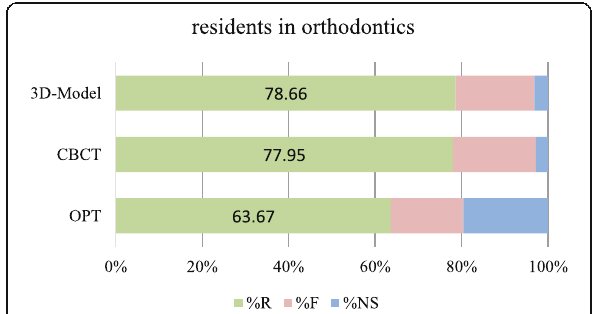
Fig. 2 Accuracy of diagnostic answers given by residents in orthodontics (R right, F false, NS not